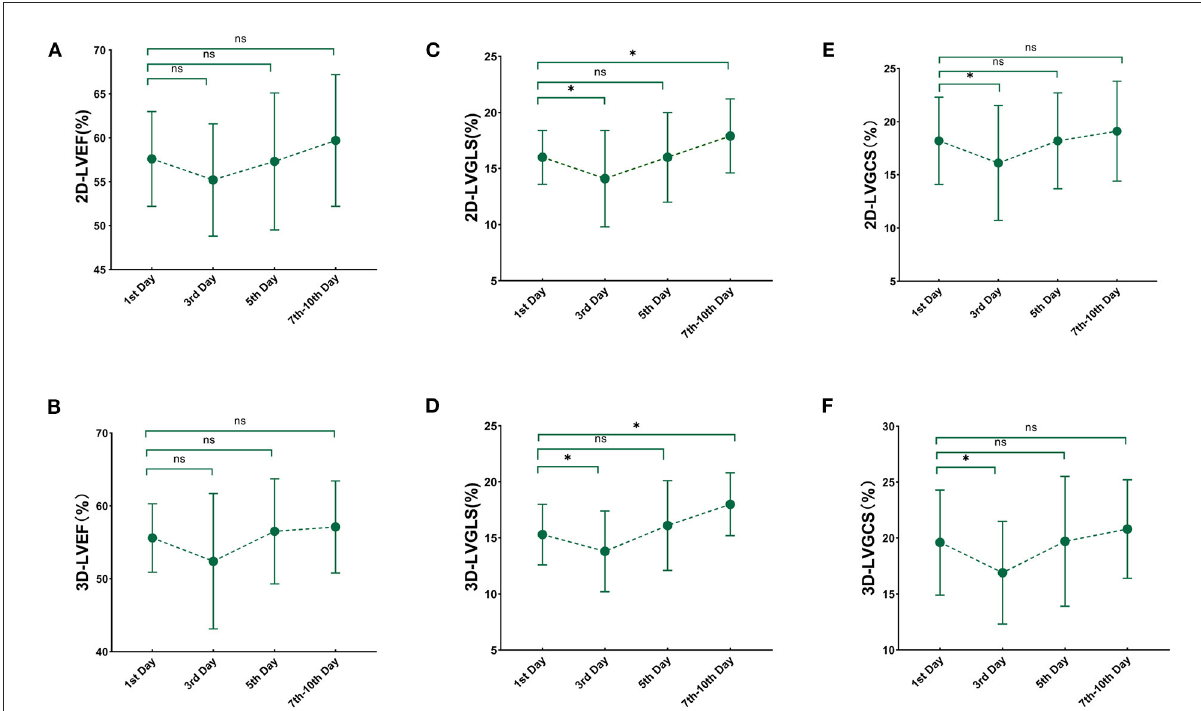
FIGURE2 Serial changes in 3D and 2D echocardiography paremeters over time. Line chart for 3D and 2D echocardiography at each time point after sepsis and septic shock. (A) 2D-LVEF; (B) 3D- LVEF; (C) 2D-LVGLS; (D) 3D-LVGLS; (E) 2D-LVGCS; (F) 3D-LVGCS. LVEF, left ventricular ejection fraction; GLS, global longitudinal strain; GCS, global circumferential strain; 2D, two-dimensional; 3D, three-dimensional. * p' < 0.05 comparison to 1st